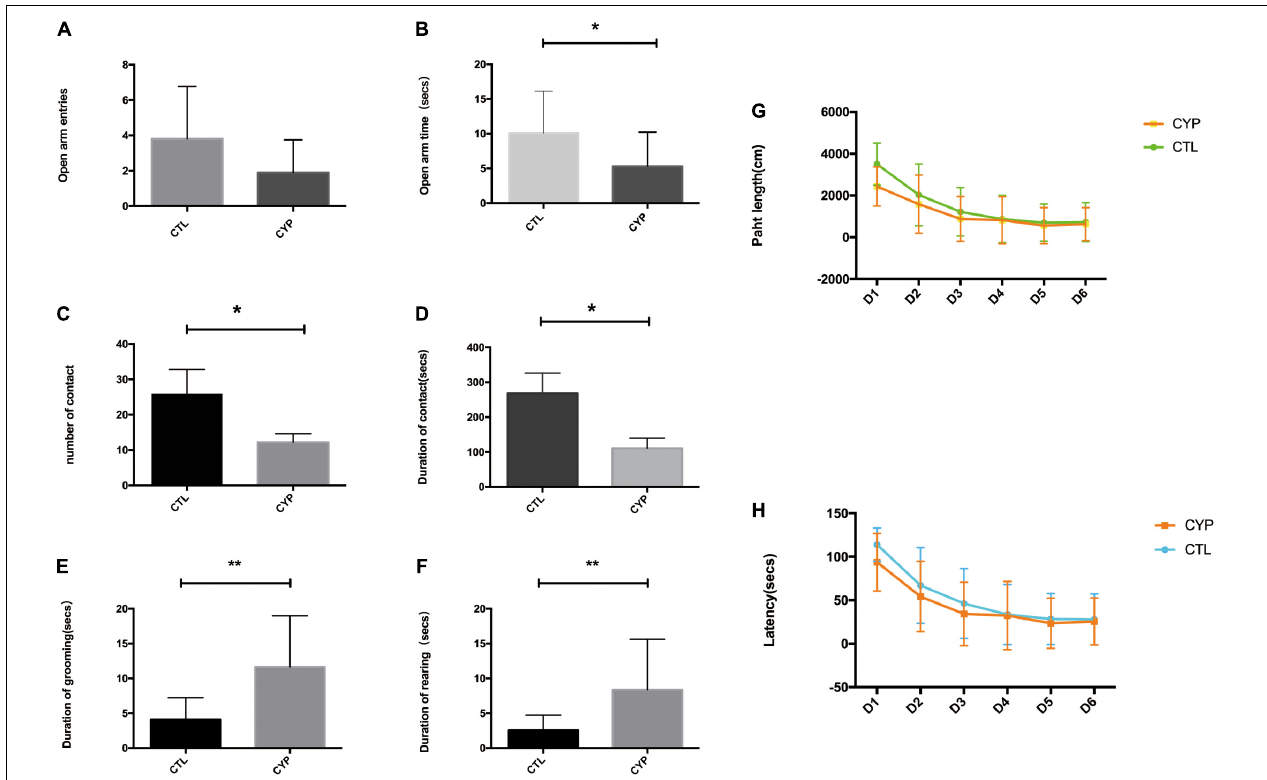
FIGURE 2 | CYP11A1 overexpression in pregnant rats increased anxiety behaviors and reduced social behaviors in their offspring. (A,B) Comparisons of entries and times spent in the open arms of the elevated plus maze. Although there was no difference between the offspring of the CYP11A1 -overexpressing and control groups in the number of entries into the open arms ( N = 16 for control and N = 10 for CYP11A1 - overexpressing group), the times spent in the open arms were significantly shorter for the offspring of CYP11A1 -overexpressing dams ( N = 16 for control, and N = 12 for CYP11A1 - overexpressing group). (C,D) The social experiments revealed that the number and duration of contacts were lower for the offspring of CYP11A1 -overexpressing dams ( N = 9 for control, and N = 18 for CYP11A1 - overexpressing group). (E,F) The incidences of grooming and rearing were significantly increased for the offspring of the CYP11A1 -overexpressing group ( N = 20 for control and N = 23 for CYP11A1 - overexpressing group). (G,H) There were no significant differences between the offspring of the two groups in terms of the latency and path length results of the water maze test ( N = 25 for control and N = 20 for CYP11A1 - overexpressing group) (* P < 0.05, ** P < 0.01).